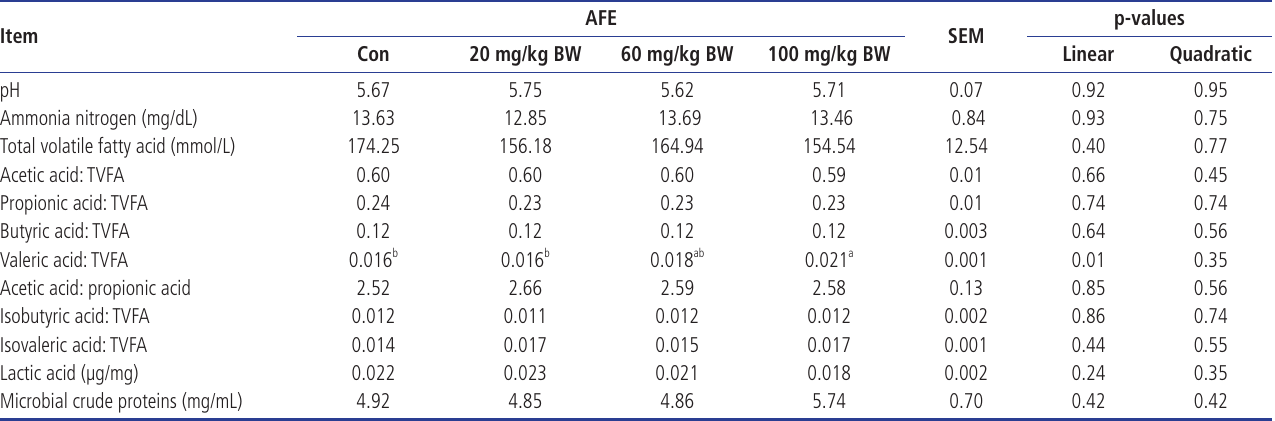
Table 8. Effects of AFE on ruminal fermentation parameters of dairy cows